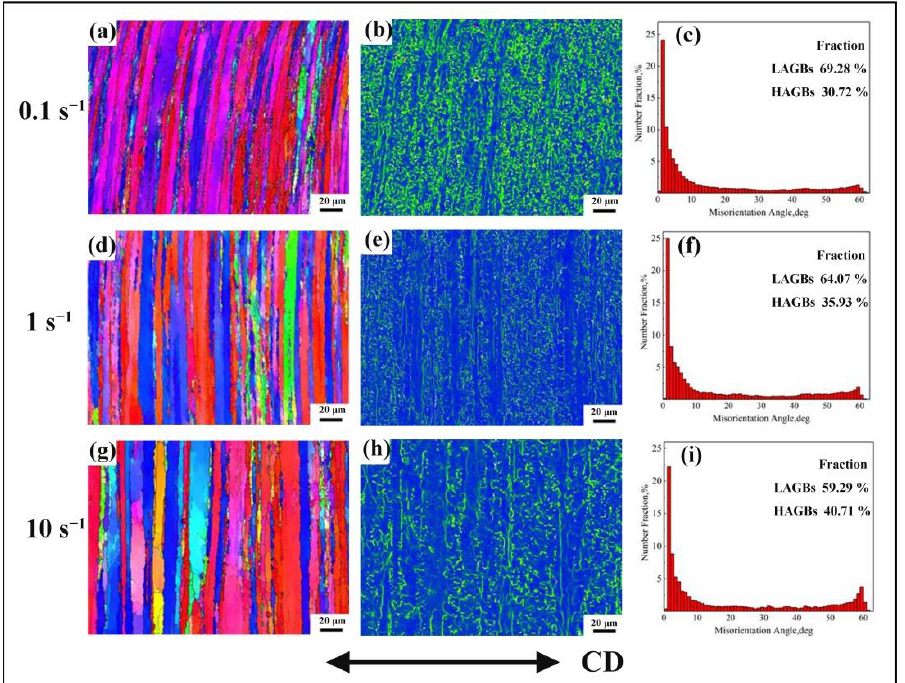
Figure 13. IPF maps, KAM maps and statistics of misorientation angle at different strain rates (T = 673 K) ( a – c ) 𝜀̇ = 0.1 𝑠 −1 ; ( d – f ) 𝜀̇ = 1 𝑠 −1 ; ( g – i ) 𝜀̇ = 10 𝑠 −1 .